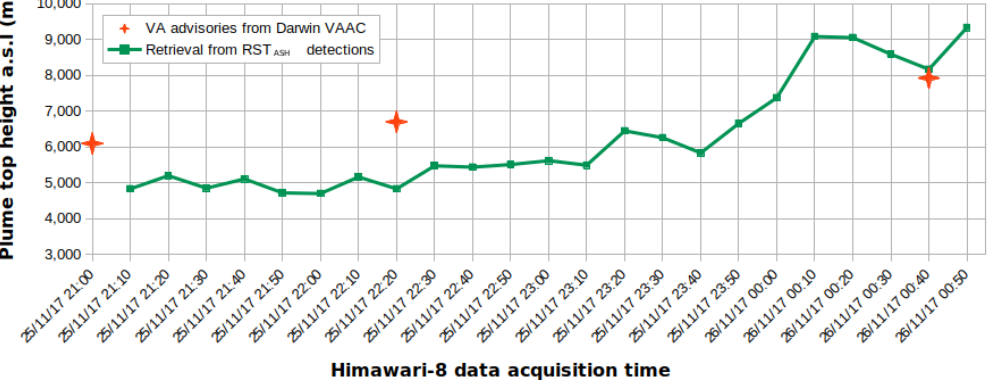
Figure 6. In green, temporal trend of the ash plume-top height (with a 10 min temporal sampling) during 25 November at 21:10 UTC – 26 November at 00:50 UTC, retrieved from ash maps of Figure 5 by using the cloud-top temperature method; in red, values of the plume height reported by VA advisory from Darwin VAAC.